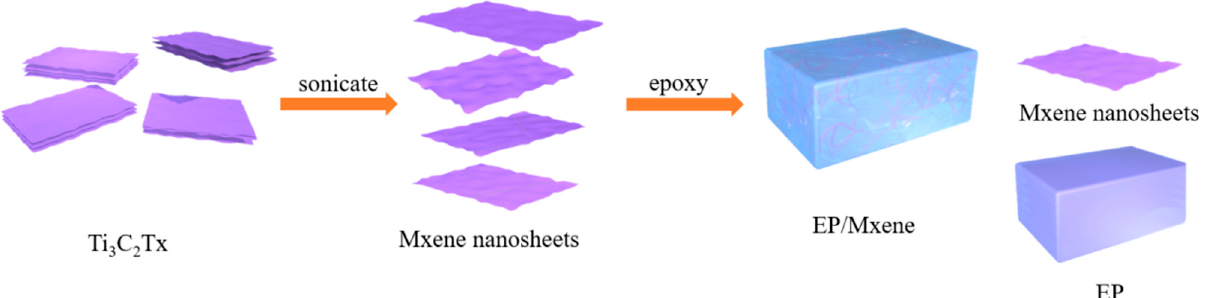
Figure 1. The flow chart of MXene/epoxy resin preparation.